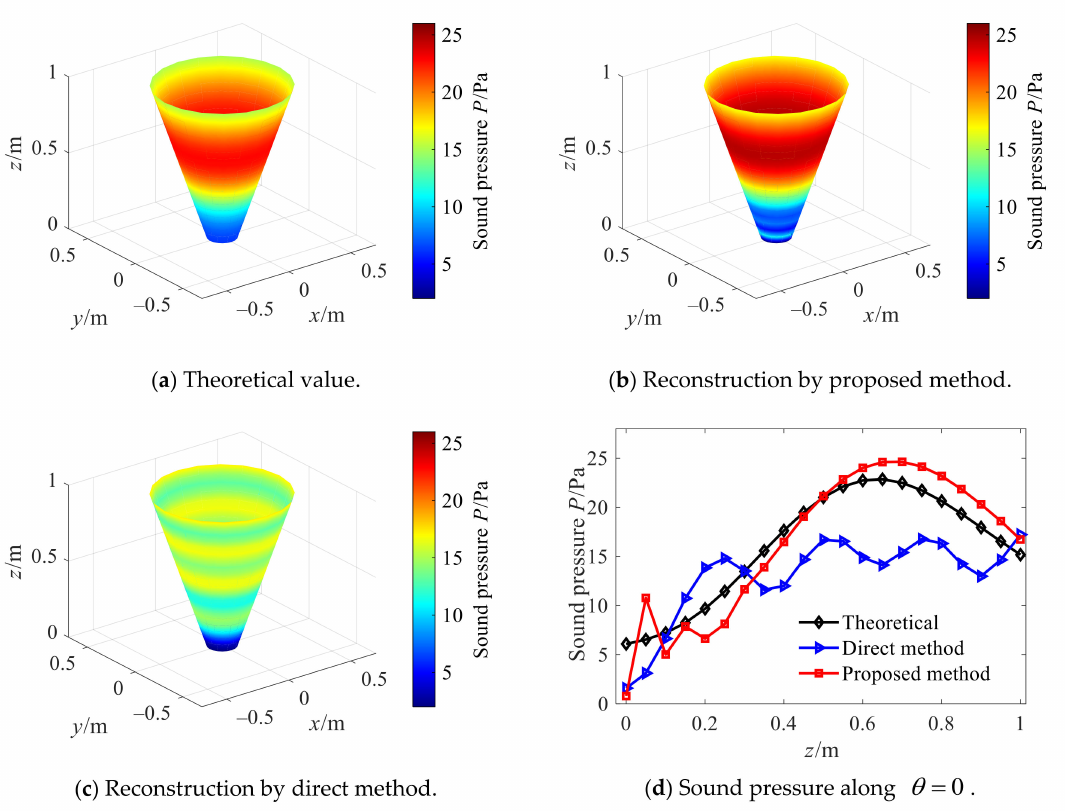
Figure 10. Reconstruction with cone angle 40 ◦ .